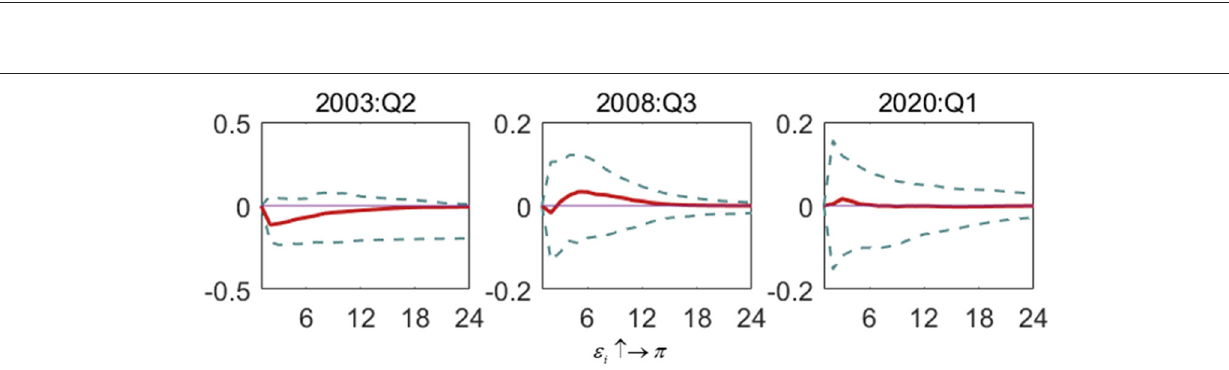
FIGURE 3 | The impulse response of the output gap to inflation gap shock in special periods. Each subfigure demonstrates three special periods, including the SARS outbreak period (2003:Q2), the global financial crisis period (2008:Q3) and the COVID-19 outbreak period (2020:Q1). One period in the figure denotes one season.